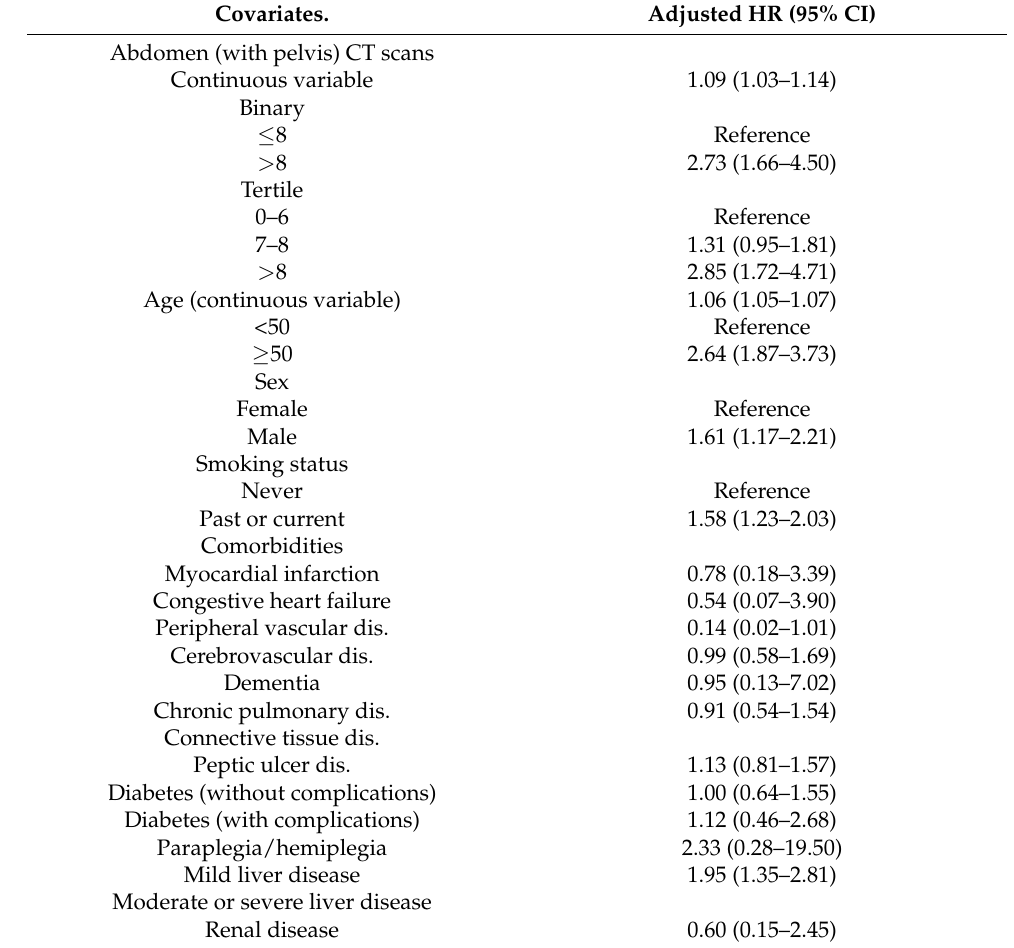
Estimated from Cox proportional hazard models and the multivariable model included all the above variables; SPM, second primary malignancy; HR, hazard ratio; CI, confidence